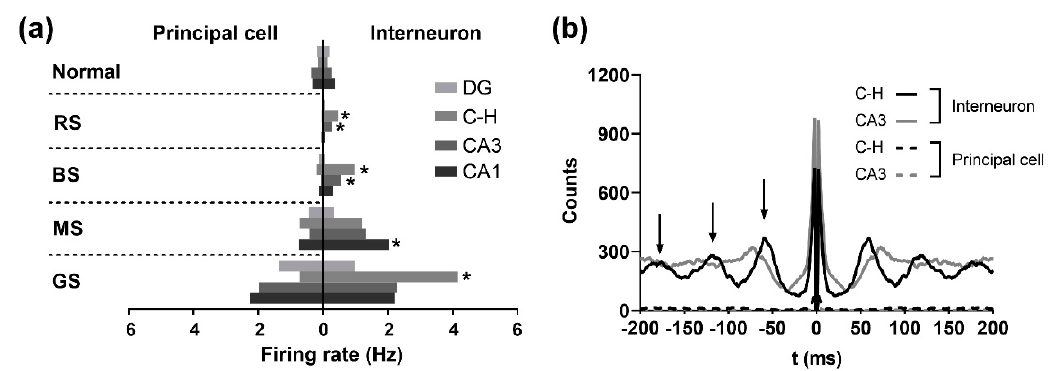
Figure 7. Comparison of spike firing rates and autocorrelograms of principal cells and interneurons. ( a ) Spike firing rates of principal cells and interneurons were dramatically increased after the induction of seizure. The firing rates were compared between principal cells and interneurons in the normal stage, resting state (RS), beginning state (BS), middle stage (MS), and grand mal stage (GS). (Principal cells: n = 16, 23, 17, and 12 in the DG, the hilus, CA3, and CA1; interneurons, n = 12, 9, 20, and 12 in the DG, the hilus, CA3, and CA1.) ( b ) Autocorrelograms of principal cells showed no oscillations, whereas those of interneurons showed rhythmic oscillations in the hilus and CA3 areas. Black arrows indicate the oscillation peaks. * P < 0.05 (interneurons vs. principal cells in same areas), ANOVA test followed by Tukey’s post hoc test. C-H: hilus.